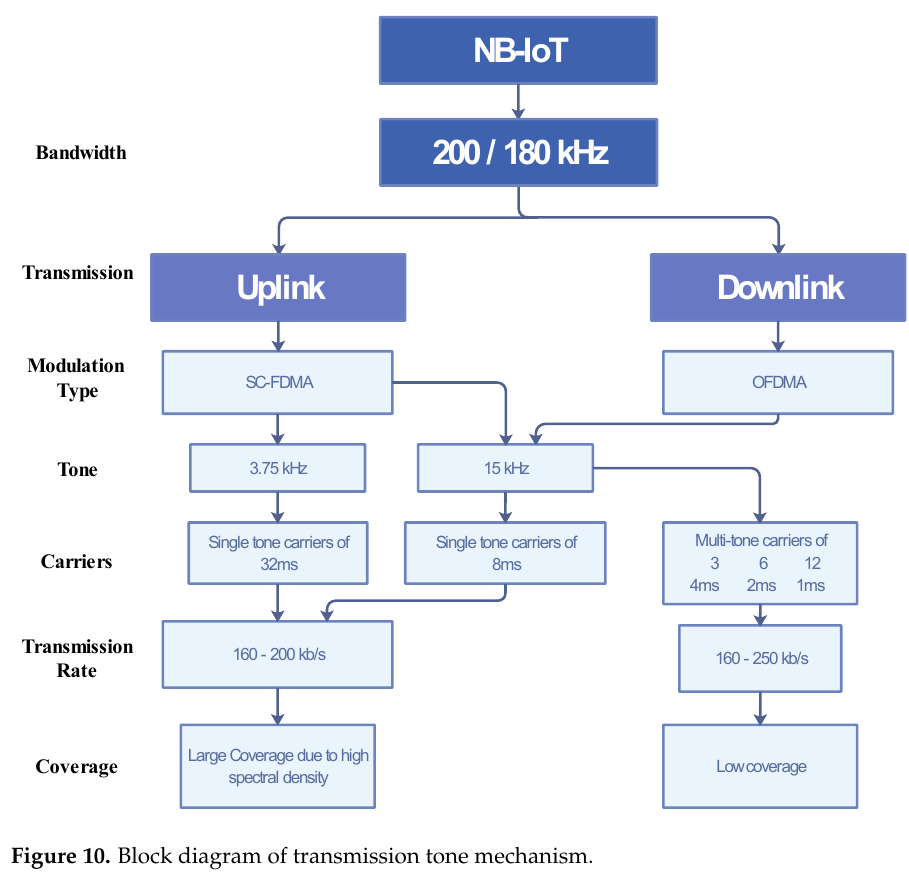
Figure 10. Block diagram of transmission tone mechanism.